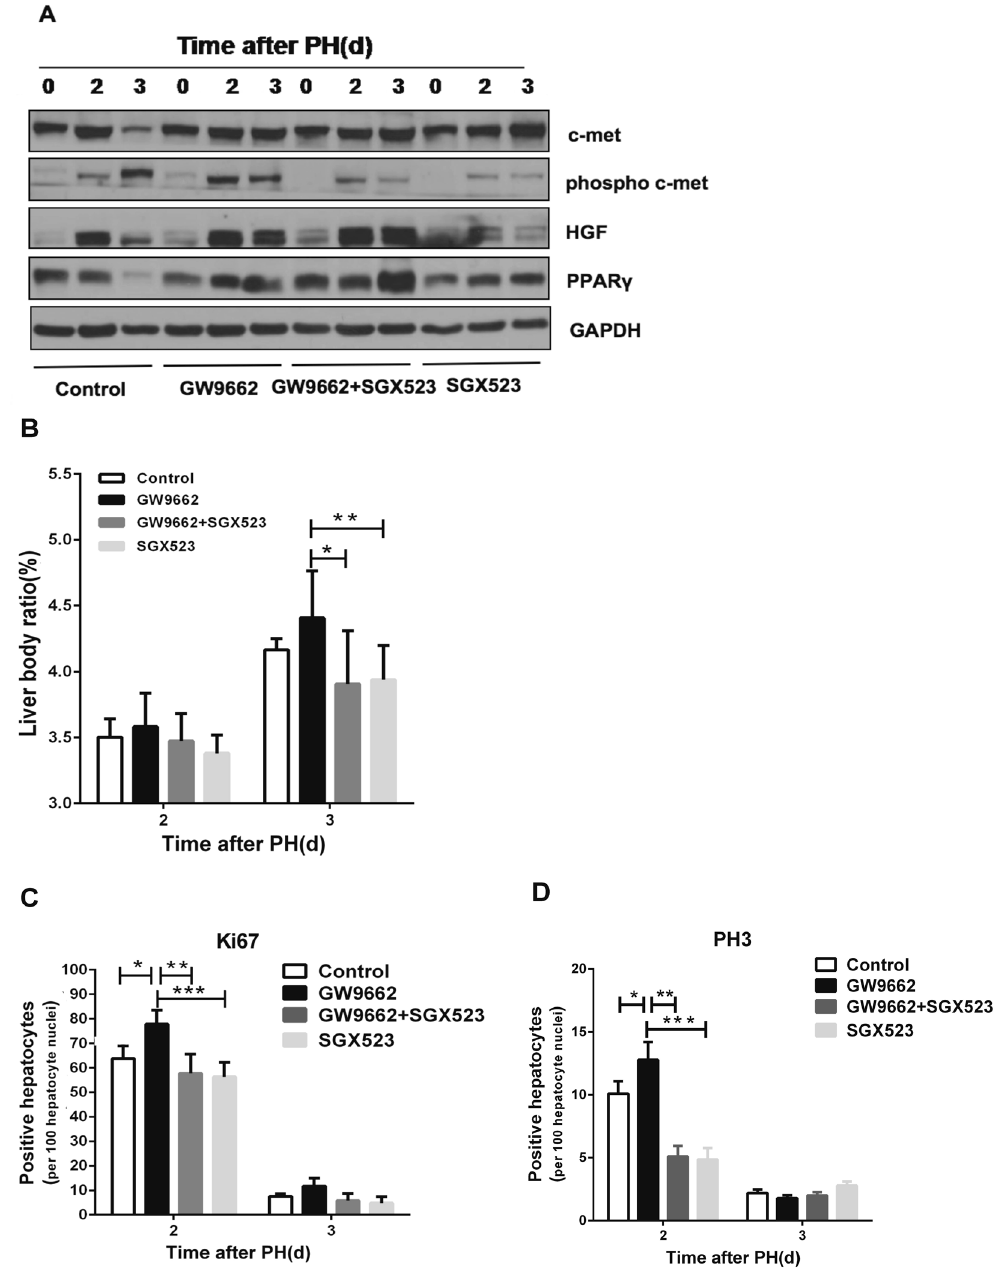
Figure 5. Inhibition of c-Met abrogates GW9662-induced liver regeneration and hepatocyte proliferation ( A ) Protein expression of PPAR γ , HGF/c-met signaling pathway in untreated mice, GW9662-treated mice, GW9662 plus SGX523-treated mice, and SGX523-treated mice at 0, 2, and 3 days after PH. ( B ) Liver to body weight ratio in control mice, GW9662-treated mice, GW9665 plus SGX523-treated mice, and SGX523-treated mice at 0, 2, and 3 days after PH. ( C ) Quantification of hepatic Ki67 expression and ( D ) PH3 expression after PH. * p < 0.05, ** p < 0.01, *** p <